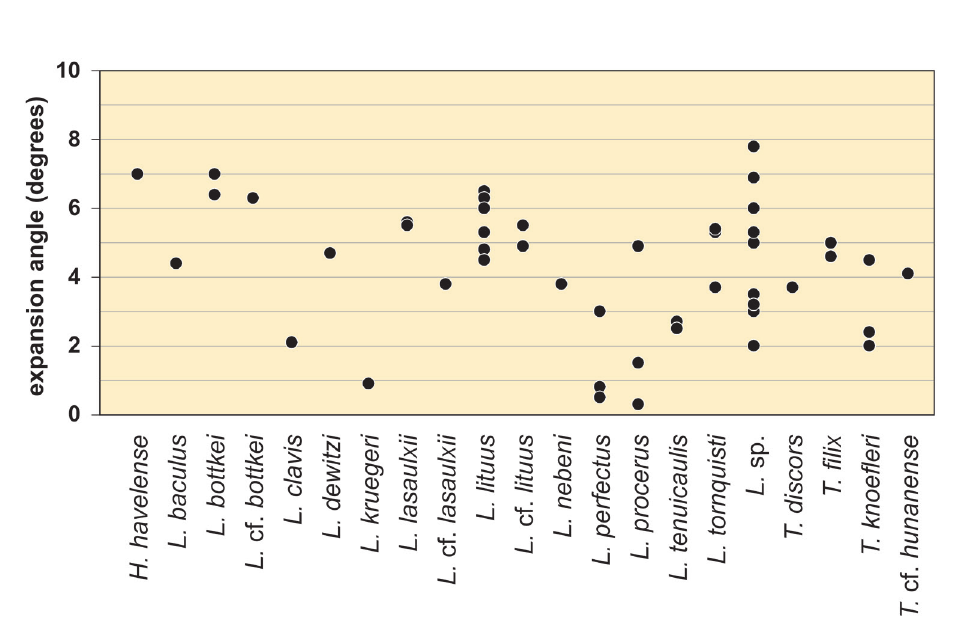
Fig. 30. Conch expansion rates in species of the Lituitidae Phillips,